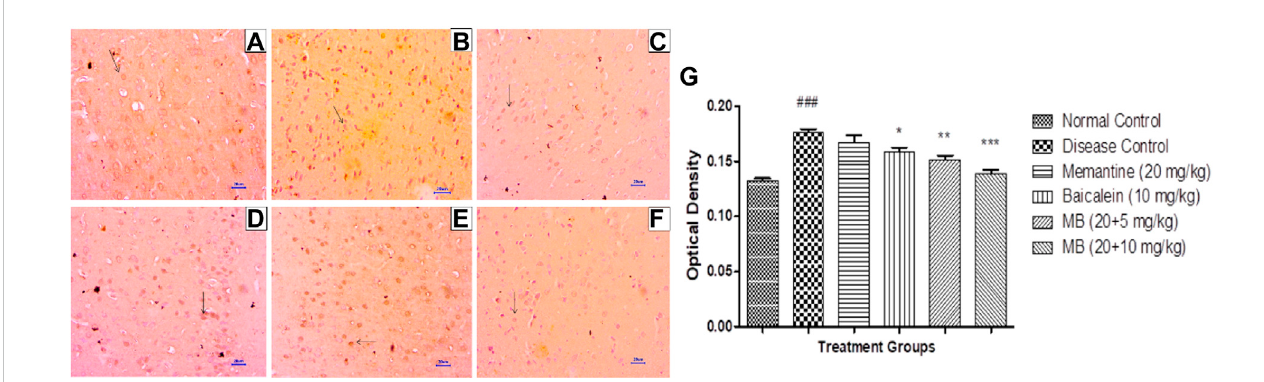
FIGURE 8 Effects of baicalein and baicalein with memantine on β -Amyloid expression in cortex tissue (400X), (A) Normal control: showing normal neuronal cells without immunoreactivity at the cortex (small arrow), (B) Disease control: showing moderately enhanced β -Amyloid expression as evidenced by the brown coloration of cortical neurons (small arrow), (C) Memantine (20 mg/kg): showing mildly enhanced β -Amyloid expression as evidenced by the brown coloration of cortical neurons (small arrow), (D) Baicalein (10 mg/kg): showing moderately enhanced β -Amyloid expression as evidenced by the brown coloration of cortical neurons (small arrow), (E) Memantine + baicalein (20+5 mg/kg): showing mildly enhanced β -Amyloid expression as evidenced by the brown coloration ofcorticalneurons (small arrow), (F) Memantine+Baicalein (20+ 10 mg/kg): showingmildly enhanced β -Amyloid expression asevidenced bythebrown colorationofcortical neurons(small arrow), (G) ODdata forICH. Dataareexpressedasmean±SEM,with ### p < 0.001 whencompared tothe normalcontrolgroup,and* p < 0.05,** p < 0.01,and*** p < 0.001whencomparedtothediseasecontrolgroup.AlCl 3 ,Aluminumchloride;SEM,Standarderror